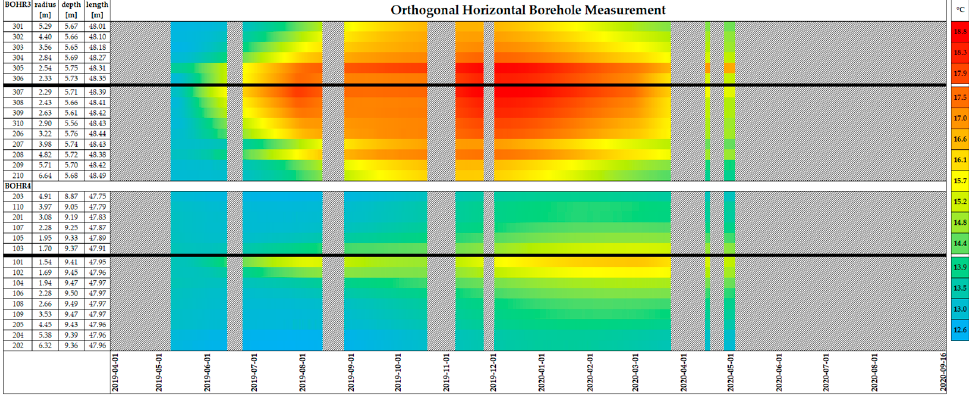
Figure 19. Orthogonal borehole temperature measurement ~48 m.